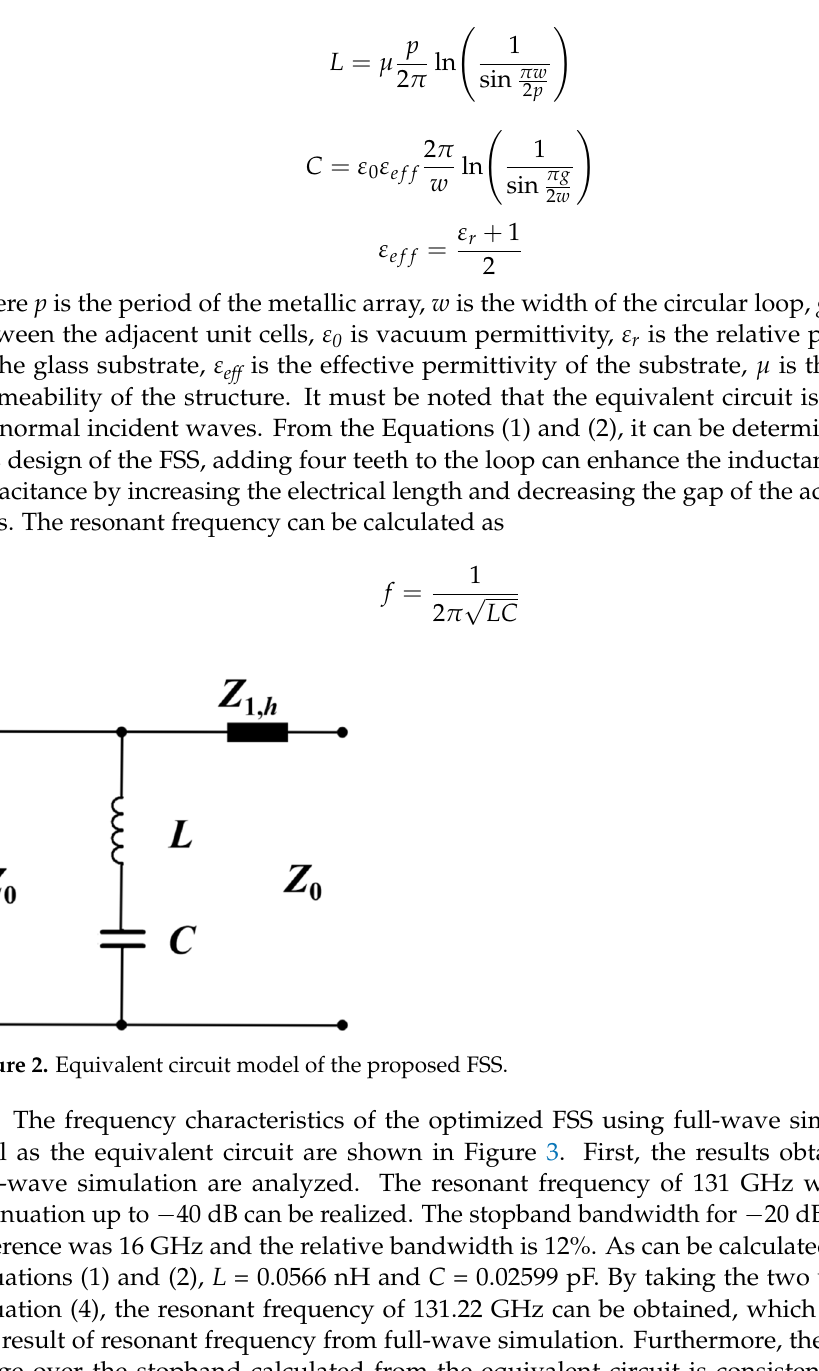
(4) The frequency characteristics of the optimized FSS using full-wave simulation as well as the equivalent circuit are shown in Figure 3. First, the results obtained from full-wave simulation are analyzed. The resonant frequency of 131 GHz with a deep attenuation up to − 40 dB can be realized. The stopband bandwidth for − 20 dB insert loss reference was 16 GHz and the relative bandwidth is 12%. As can be calculated using the Equations (1) and